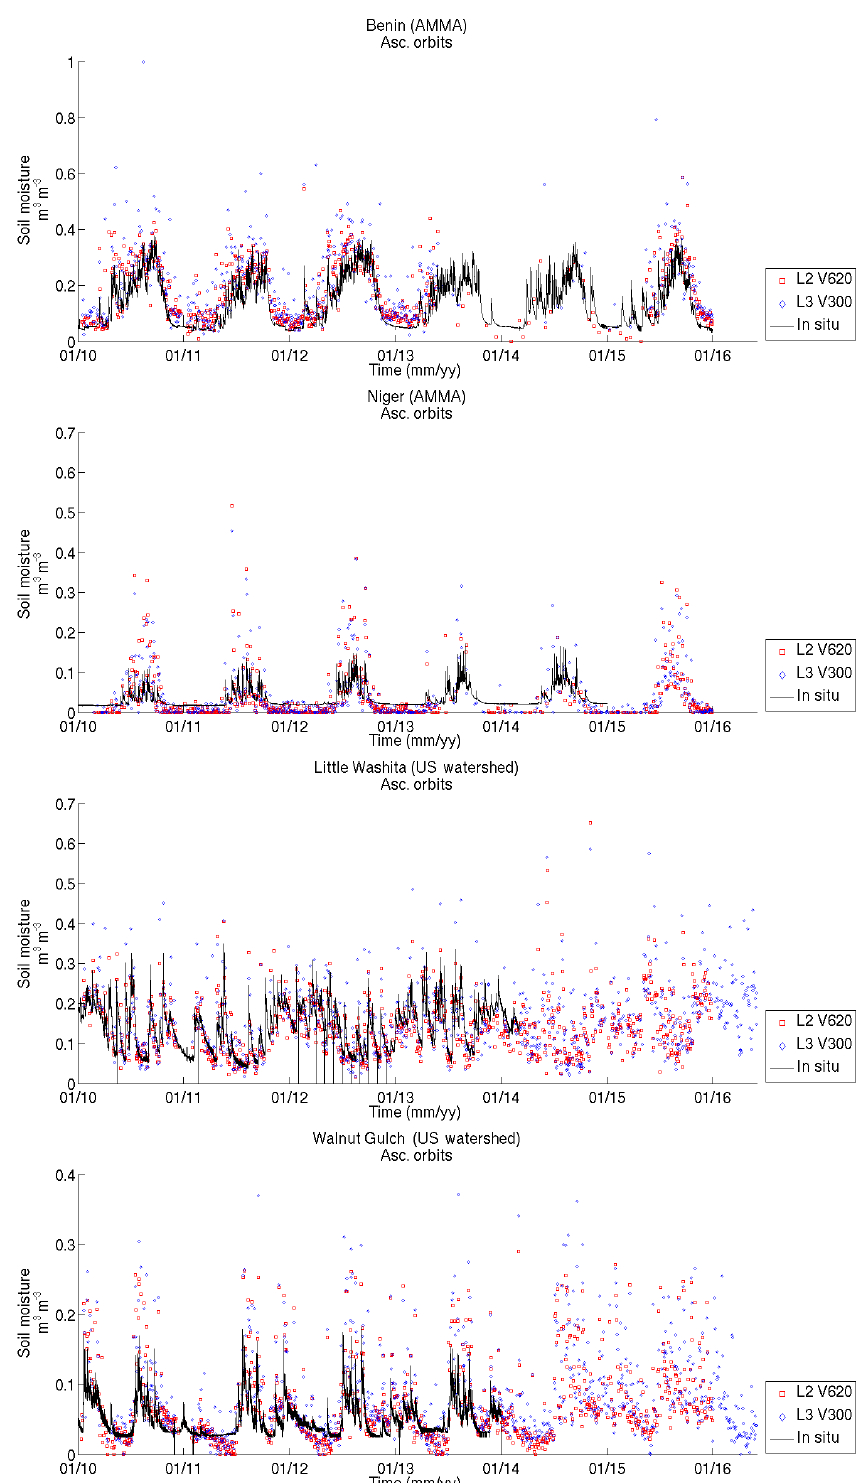
Figure 11. Time series for the validation sites for the ascending (06:00UTC) overpasses.